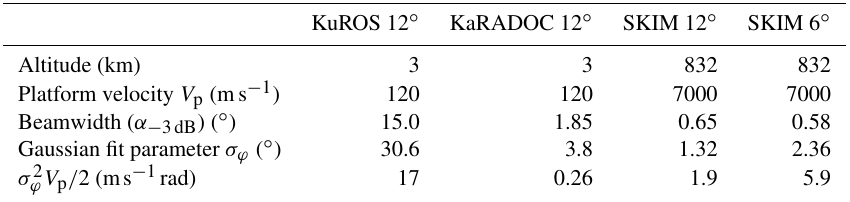
Table 5. Main differences between the KaRADOC and KuROS airborne radars used in the present article and the SKIM system as presented by the ESA (2019). The factor σ 2 ϕ V p / 2 is the prefactor of sin (ϕ − ϕ t )∂ ϕ log (σ 0 ) in the expression of U AGD . KuROS 12